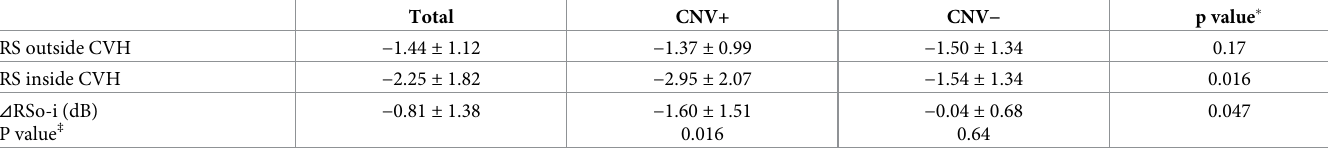
Table 2. The difference in average sensitivities between the inside and outside of CVH ( ⊿ RSo-i) in eyes with CNV (CNV+, n = 6) or without CNV (CNV − , n = 6).